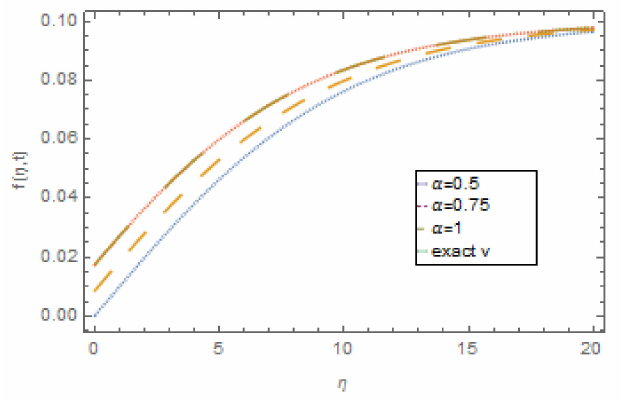
Figure 12. 2D plot of comparison of solutions.